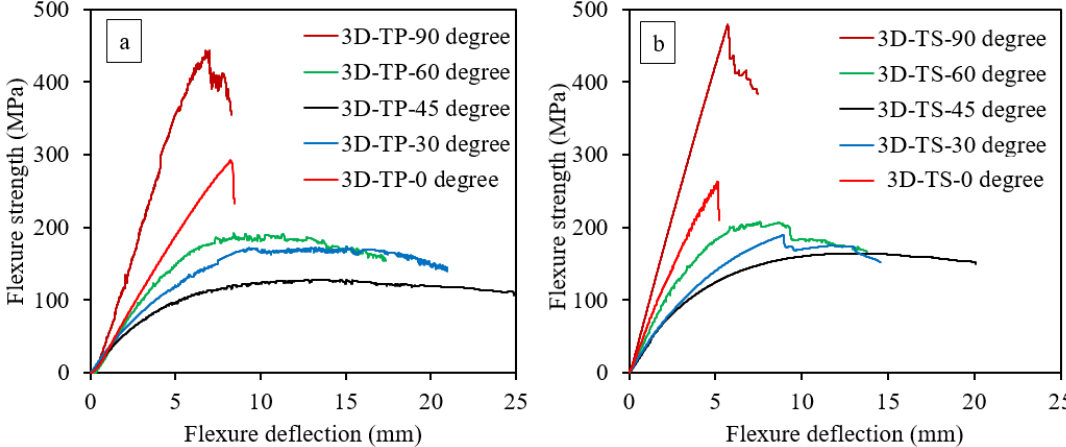
Figure 4. Effect of fibre orientation on the flexure properties of 3D-FRC, ( a ) S-D curves of 3D thermoplastic FRC and ( b ) S-D curves of 3D thermoset FRC.